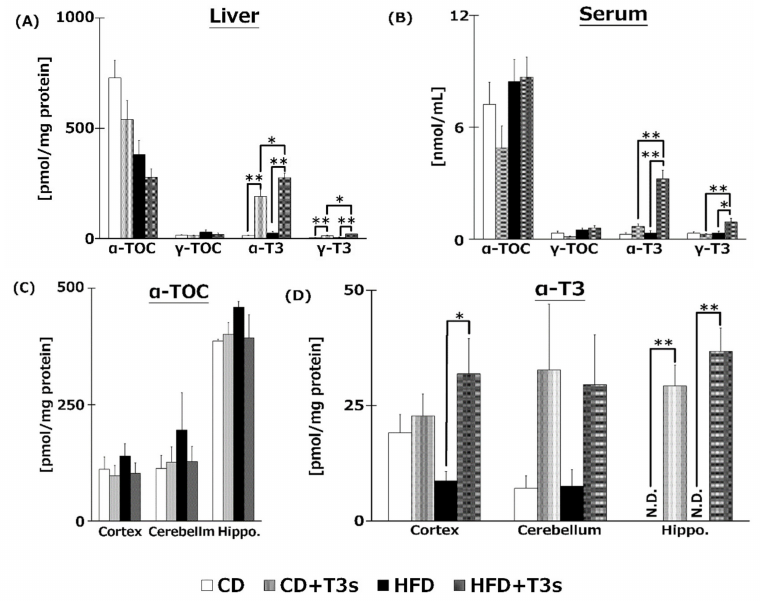
Figure 5. VE content in livers ( A ), serum ( B ), and brains ( C ), ( D ) of mice. T3s were demonstrated to reach the brain. CD = Control diet ( n = 10), CD + T3s = CD + T3 mix ( n = 10), HFD = high-fat diet ( n = 10). HFD + T3s = high-fat diet + T3 mix ( n = 10). Data are expressed as mean ± SE. Tukey–Kramer’s method: * p < 0.05, ** p <